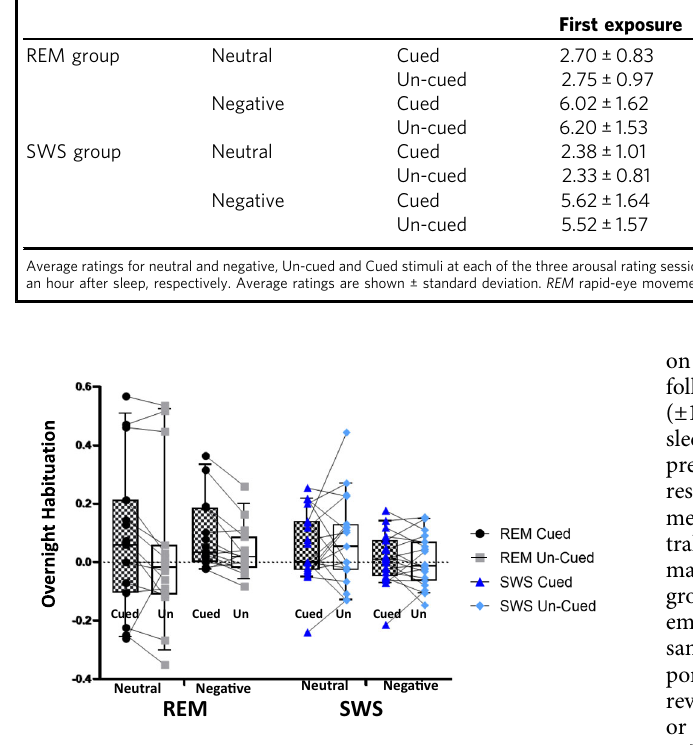
Fig. 2. Closer examination of the REM group showed that the effect of Cueing was driven by the negative items (paired test t = 3.21; p = 0.006), with neutral items showing a trend towards the same effect ( t = 1.6; p = 0.102). Interestingly, there was a main effect of emotion in the SWS group ( F (1,18) = 6.28, p = 0.022) but not in the REM group. Closer examination showed that this was driven by greater habituation of neutral items compared to negative items in the Un-cued condition ( t = 2.25, p = 0.037), with a trend in the Cued condition ( t = 1.45, p = 0.163). Memory for the sound-image pairs was near the ceiling during the pre-sleep test. On average, participants responded correctly COMMUNICATIONS BIOLOGY| (2021) 4:404